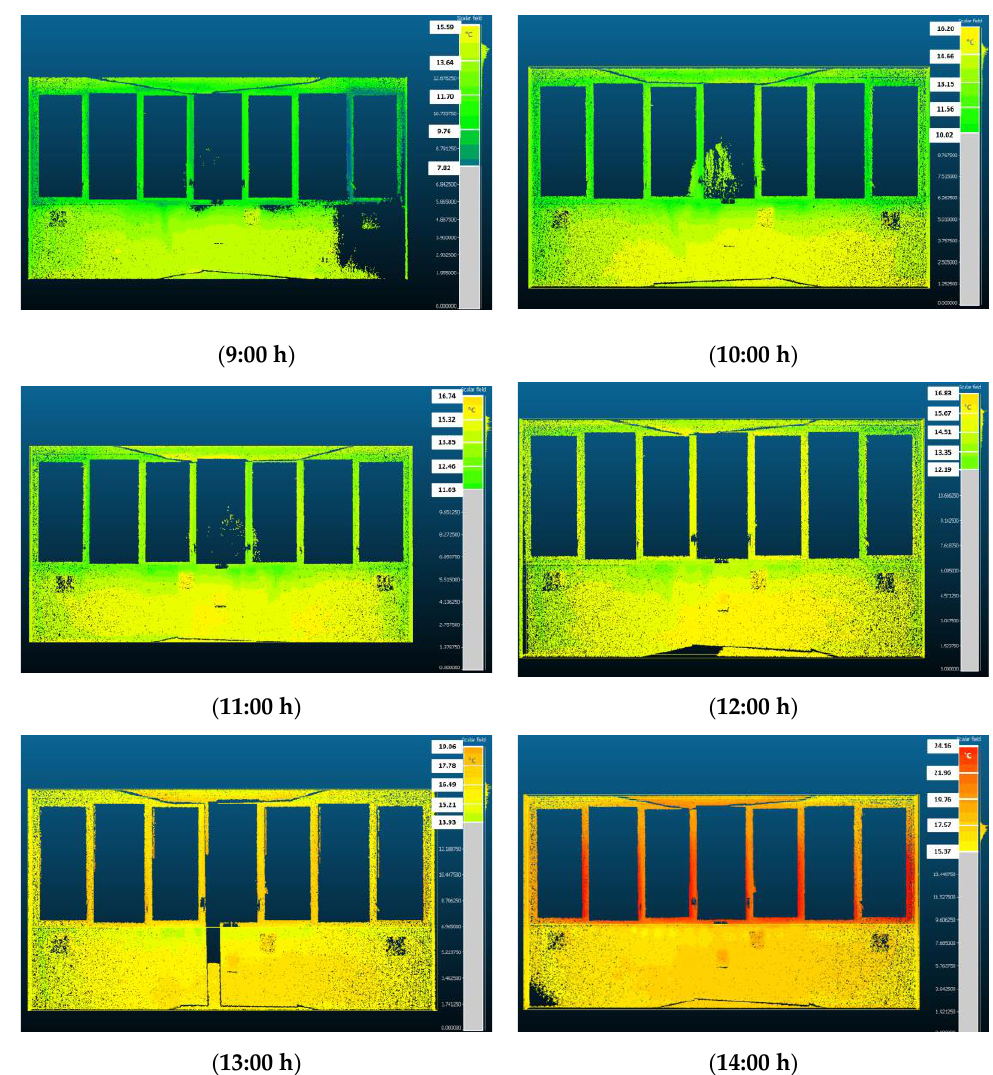
Figure 7. Series of orthoimages of the western wall, Room W, 19 November 2021.